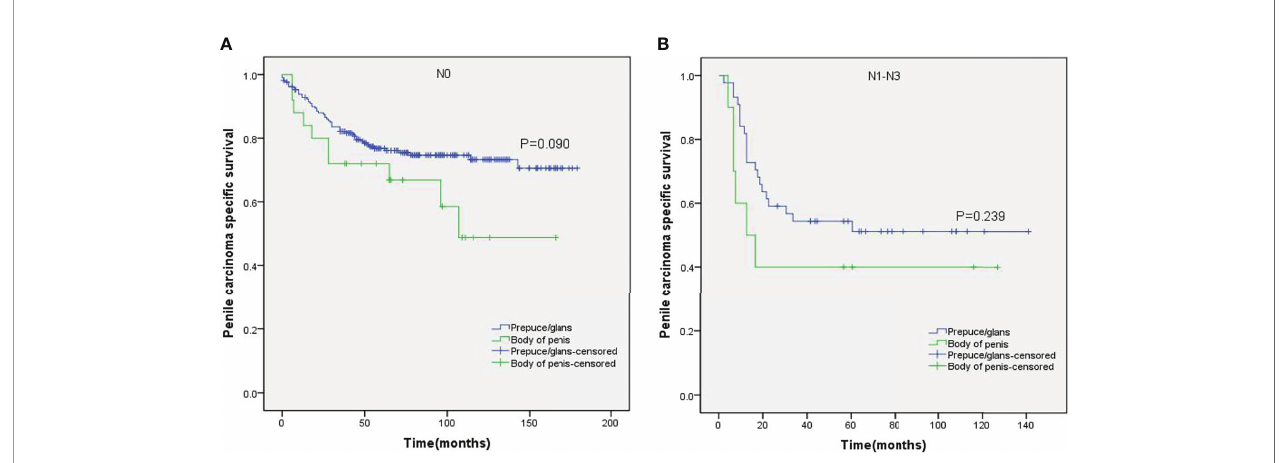
FIGURE 8 | Kaplan – Meier analyses of penile carcinoma-speci fi c survival in N0 group (A) and N1 – N3 group (B) in patients strati fi ed by tumor location.